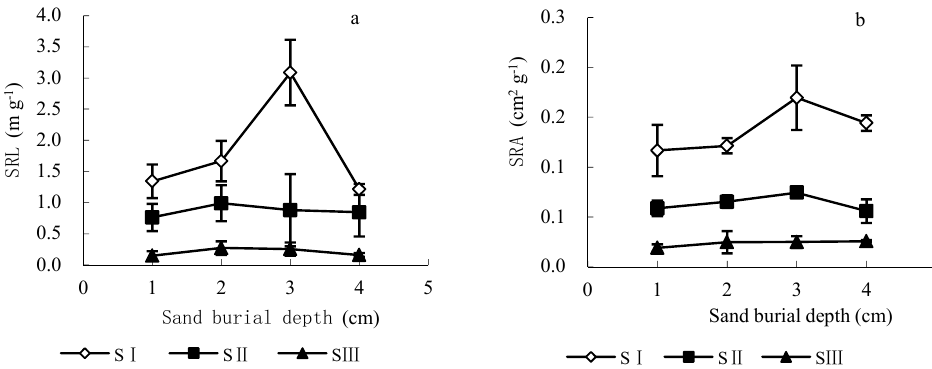
Figure 5. Effects of seed size and sand burial on seedling root characteristics of Pinus thumbergii. SRL ( a ): specific root length; SRA ( b ): specific root area. SI: large seeds; SII: medium seeds; SIII: small seedsp. Values are means ± standard deviation (SD).